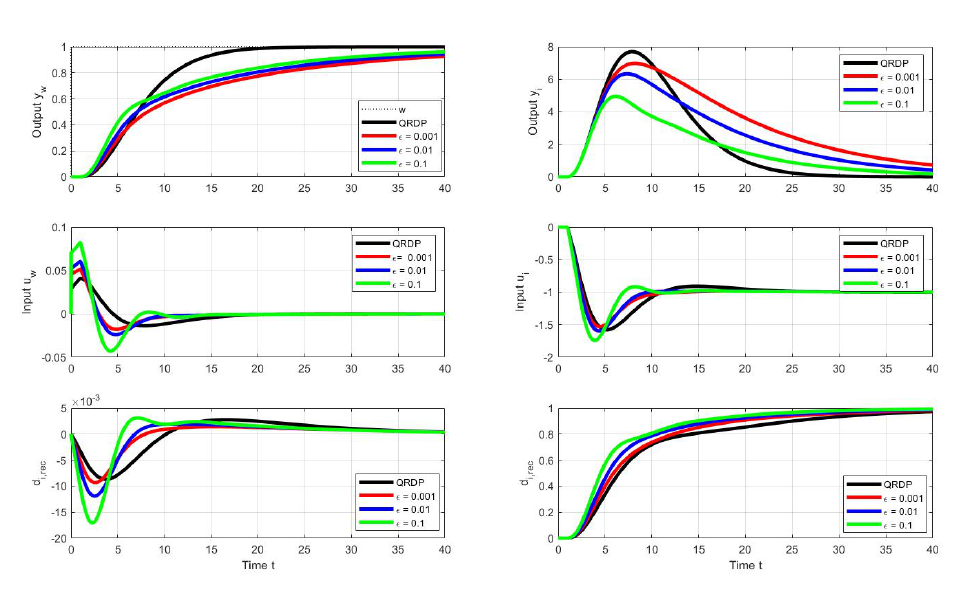
Figure 8. Unit setpoint step responses ( left ) and unit input disturbance step responses ( right ) achieved with the parallel QRDP PID controller (black) and responses corresponding to series PID controller (see Figure 9) with the optimal tuning calculated by the PPM over the parameter grid (41) under the performance specifications (53) and (44); T m = 1; K s = 1; T s = 0.001.